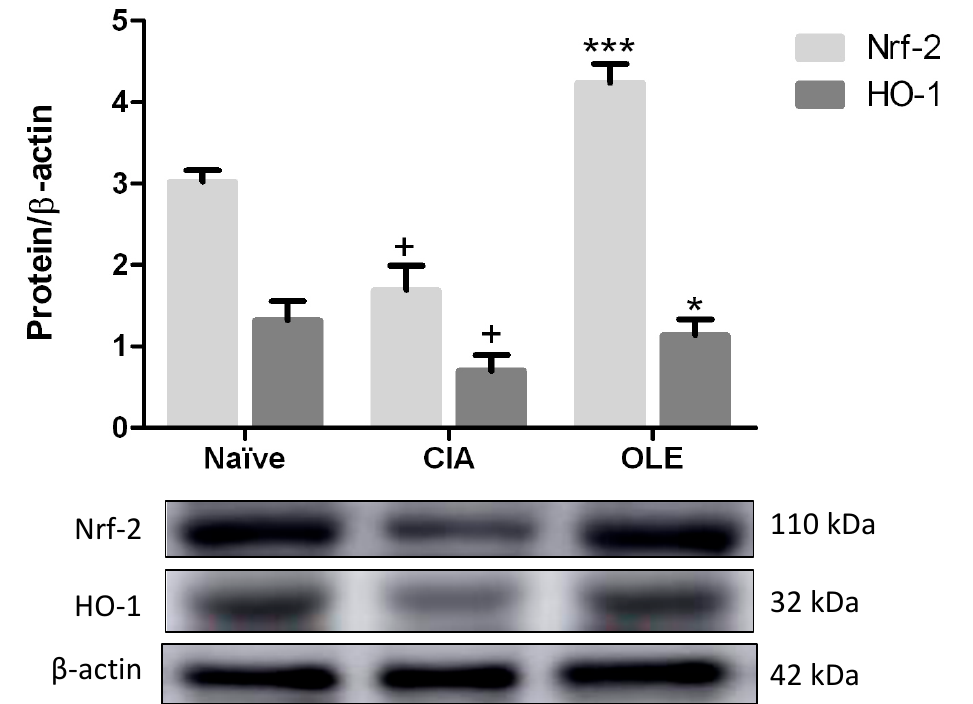
Figure 8. OLE dietary treatment induced up-regulation of Nrf-2/HO-1 protein expression in hind paws homogenates. Densitometry analysis was normalized with respect to β -actin (house-keeping). Western blot images are representative of separate experiments with similar results. Naïve group, non-arthritic control animals fed with SD; CIA, control group induced arthritic animals fed with SD; OLE induced arthritic animals fed with OLE enriched diet (0.025% w/w ). Values represented mean ± S.E.M. ( n = 8), + p < 0.05 vs. Naïve control group; * p < 0.05; *** p < 0.001 vs. CIA